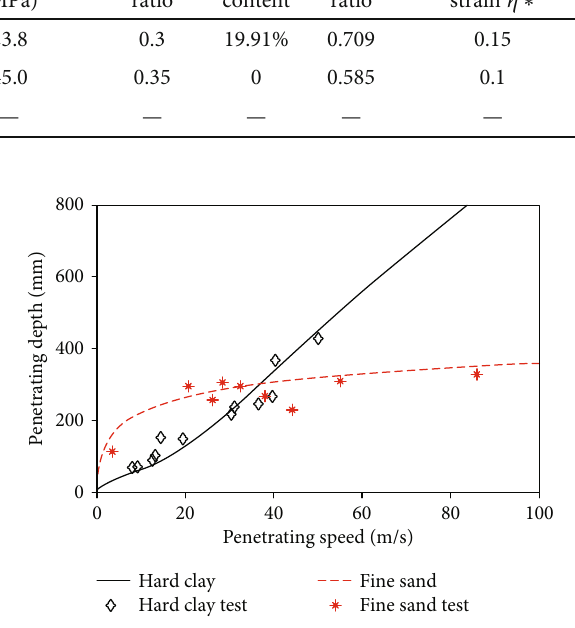
Figure 5: Results of penetration equation and experiments of anchor